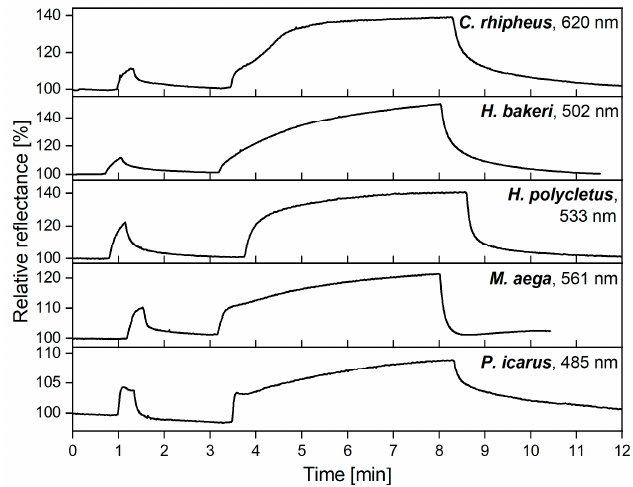
Figure 3. The first 30 s 50% ethanol vapor pulse was followed by a 5-min exposure, which resulted in saturation of the wing-based vapor sensors. After purging with synthetic air, the initial colors of the wings were retained. Both the short and long durations show specific time-dependent optical responses for the five samples. The nanometer values in the top right corners show the wavelength of the maximal spectral responses from which the time-dependent signals were generated.